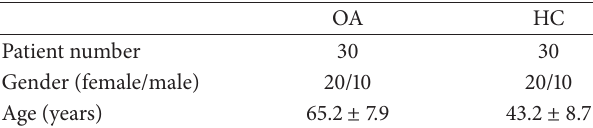
Table 2: Demographics of patients with OA and healthy controls from which blood samples were